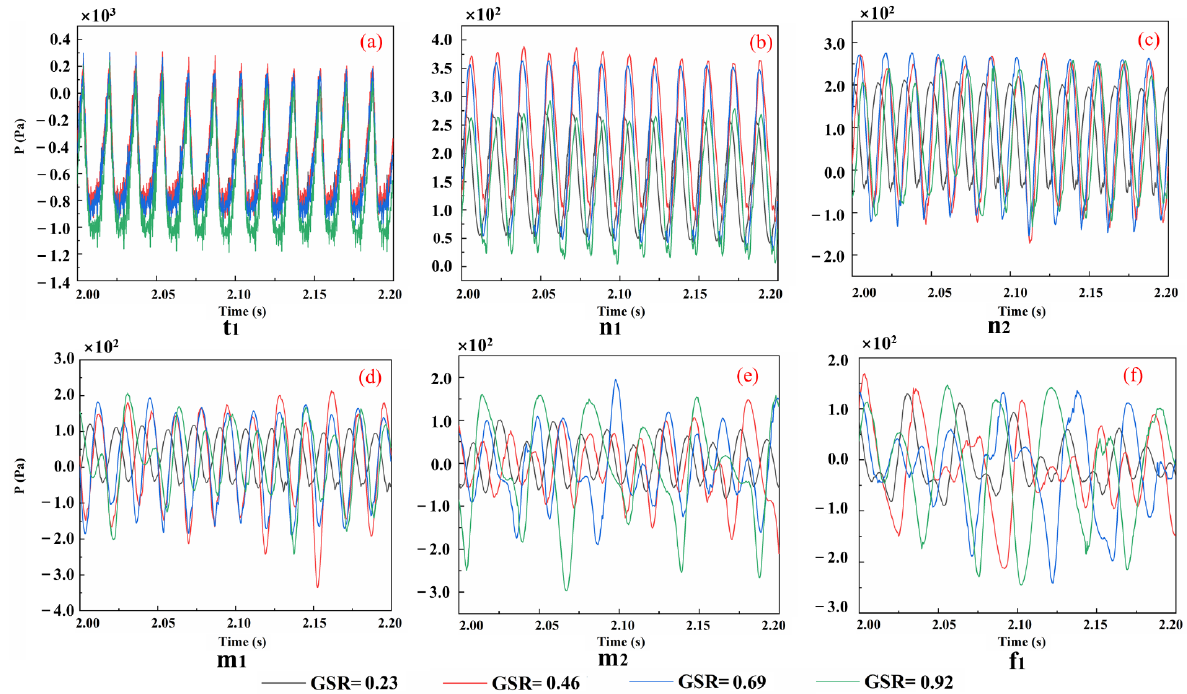
Figure 16. Diagram of pressure–time changes at the measuring points: ( a ) The time history of pressure at t 1 measuring point; ( b ) The time history of pressure at n 1 measuring point; ( c ) The time history of pressure at n 2 measuring point; ( d ) The time history of pressure at m 1 measuring point; ( e ) The time history of pressure at m 2 measuring point; ( f ) The time history of pressure at f 1 meas- uring point.